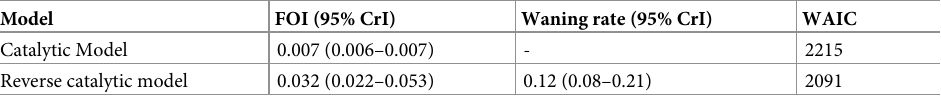
Table 1. Parameter estimates for the force of infection (FOI) and waning rate from the catalytic and reverse cata- lytic model (median [95% CrI]). Model